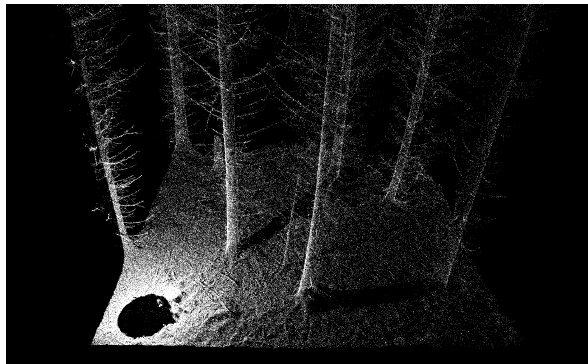
Figure 1. Example of a point cloud from a laser scanned forest plot. Shading occur behind the trees and under the measuring instrument. The number of shaded areas can be reduced if several instrument positions are